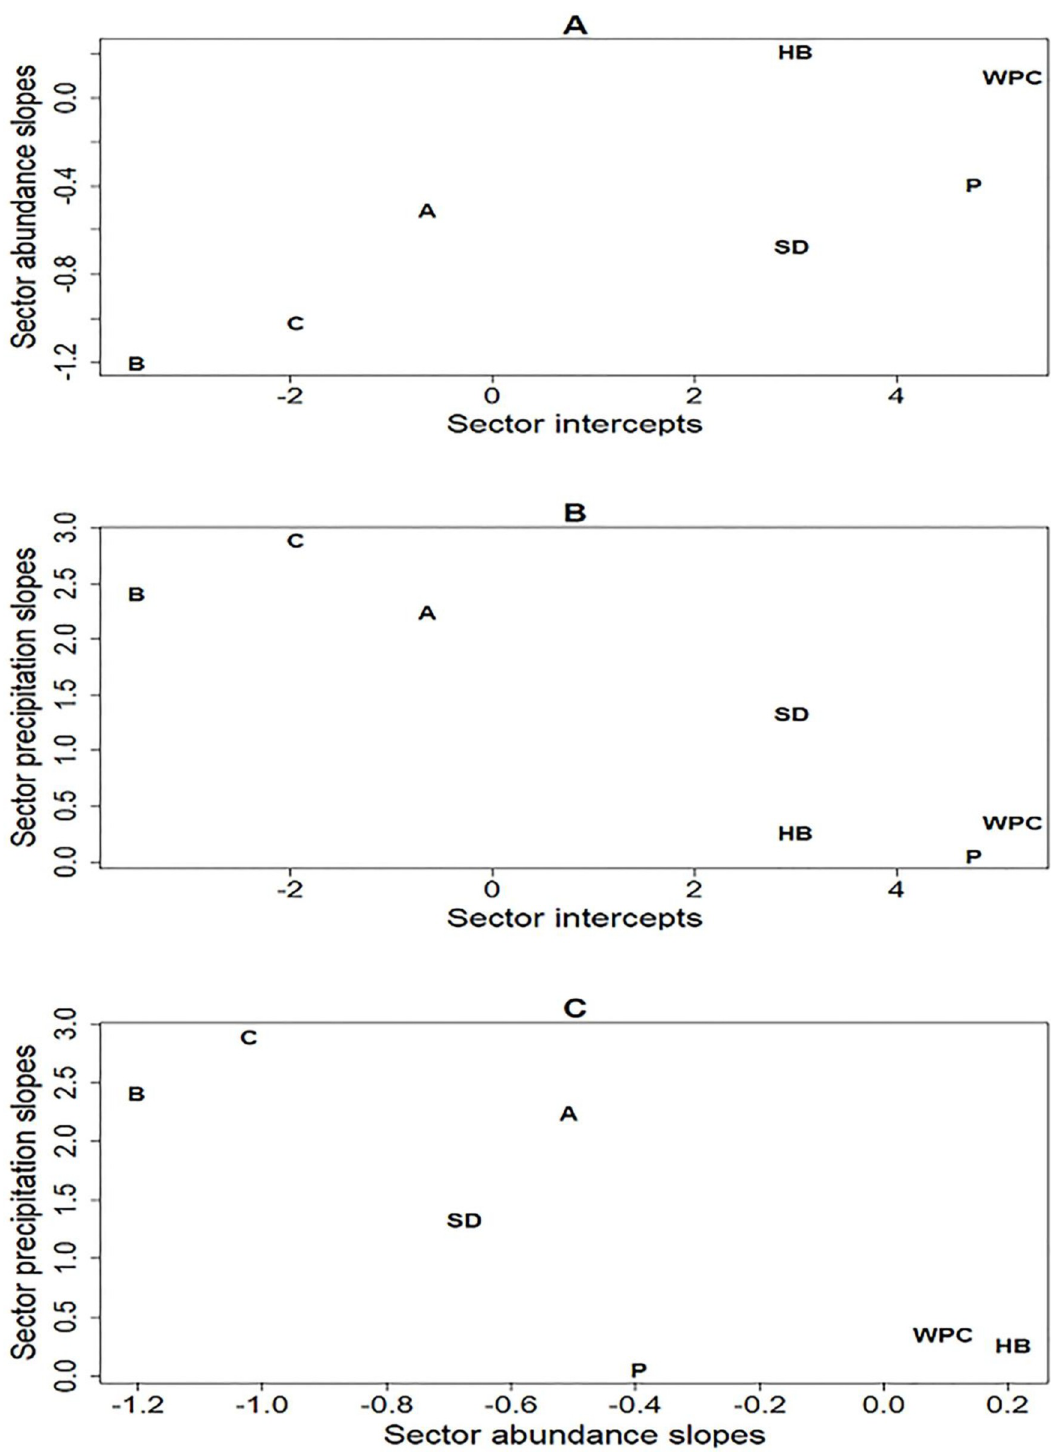
Fig 3. Scatterplots of pairwise comparisons of sector-specific regression coefficients estimated by the linear mixed effect model in the 7 sectors continually grazed across the 15 years of the study. In A are intercepts and slope coefficients of relationships between elk abundance and forage biomass. In B are intercepts and slope coefficients of relationships between precipitation from October to December and forage biomass. In C are slope coefficients of relationships between elk abundance and forage biomass, and precipitation and forage biomass. Letters or initials identify sectors: HB is horse barn, P is picnic, and SD is south Davison.